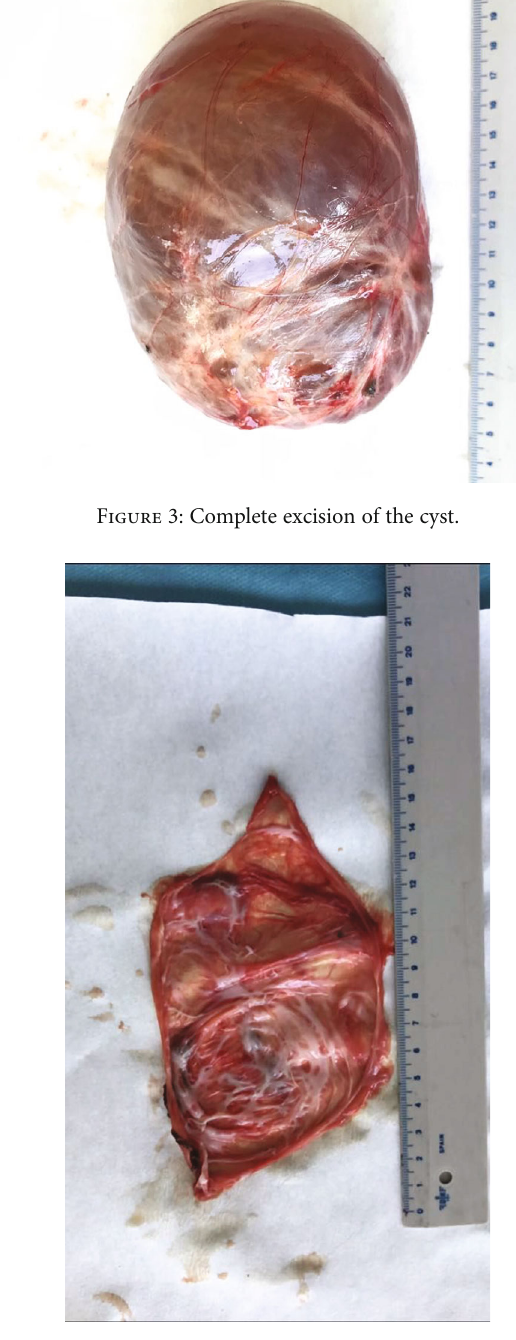
Figure 4: A thin-layered cyst with a focal fusion of the inner monolayer of the